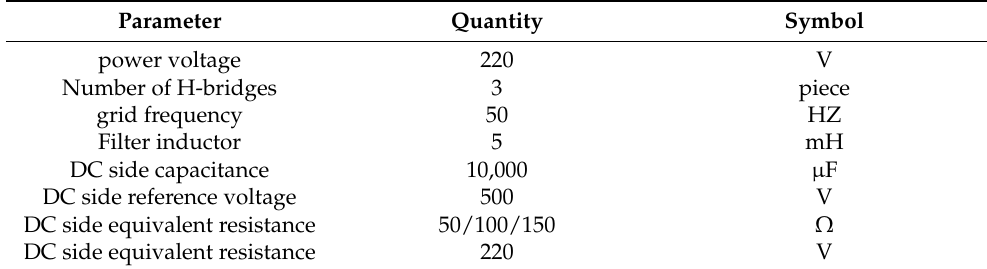
Table 3. MATLAB/Simulink simulation parameters.